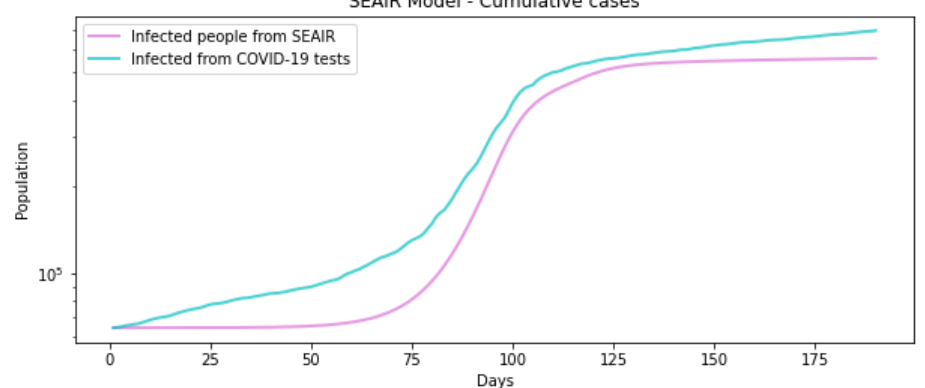
Figure 10. Comparison of cumulative infected people between SEAIR model and COVID-19 tests in Belgium. Second wave.